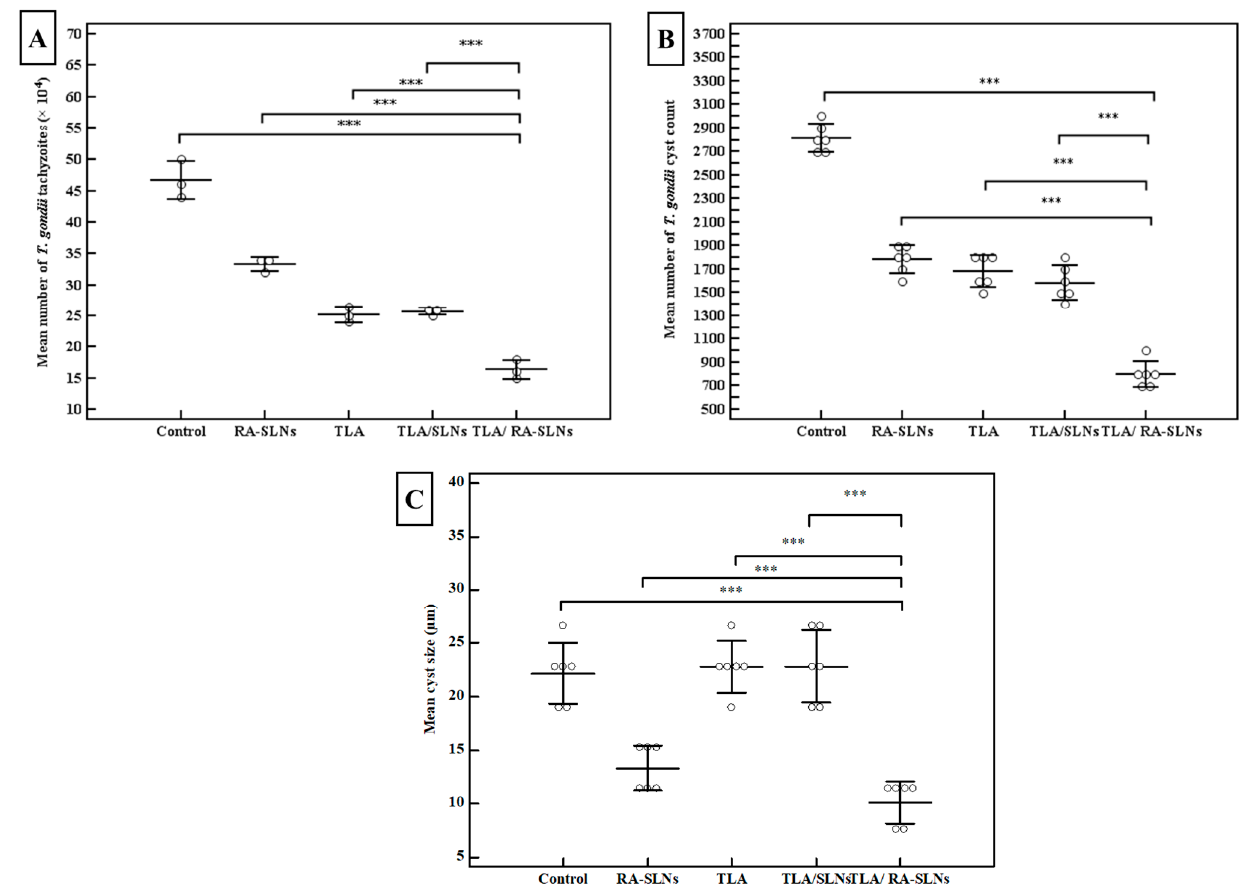
Figure 4. Results of the parasitological studies. ( A ) The tachyzoite invasion and replication assay. The tachyzoites were pre-incubated with sera collected on day zero from naive mice, or sera collected on day 42 from the start of the experiment (before infection) from mice vaccinated with various vaccination protocols. The dots symbolize the mean of T. gondii tachyzoites/well (×10 4 ) in the supernatant of Vero cell culture after incubation. All in vitro assays were performed using pooled serum samples in triplicates and the data shown represent the results of three independent experiments, ( B ) the mean of T. gondii cyst count and ( C ) cyst size in brain of mice of different evaluated groups at the 4th week after the in vivo infection. Data are expressed as mean ± SD. *** p < 0.001.